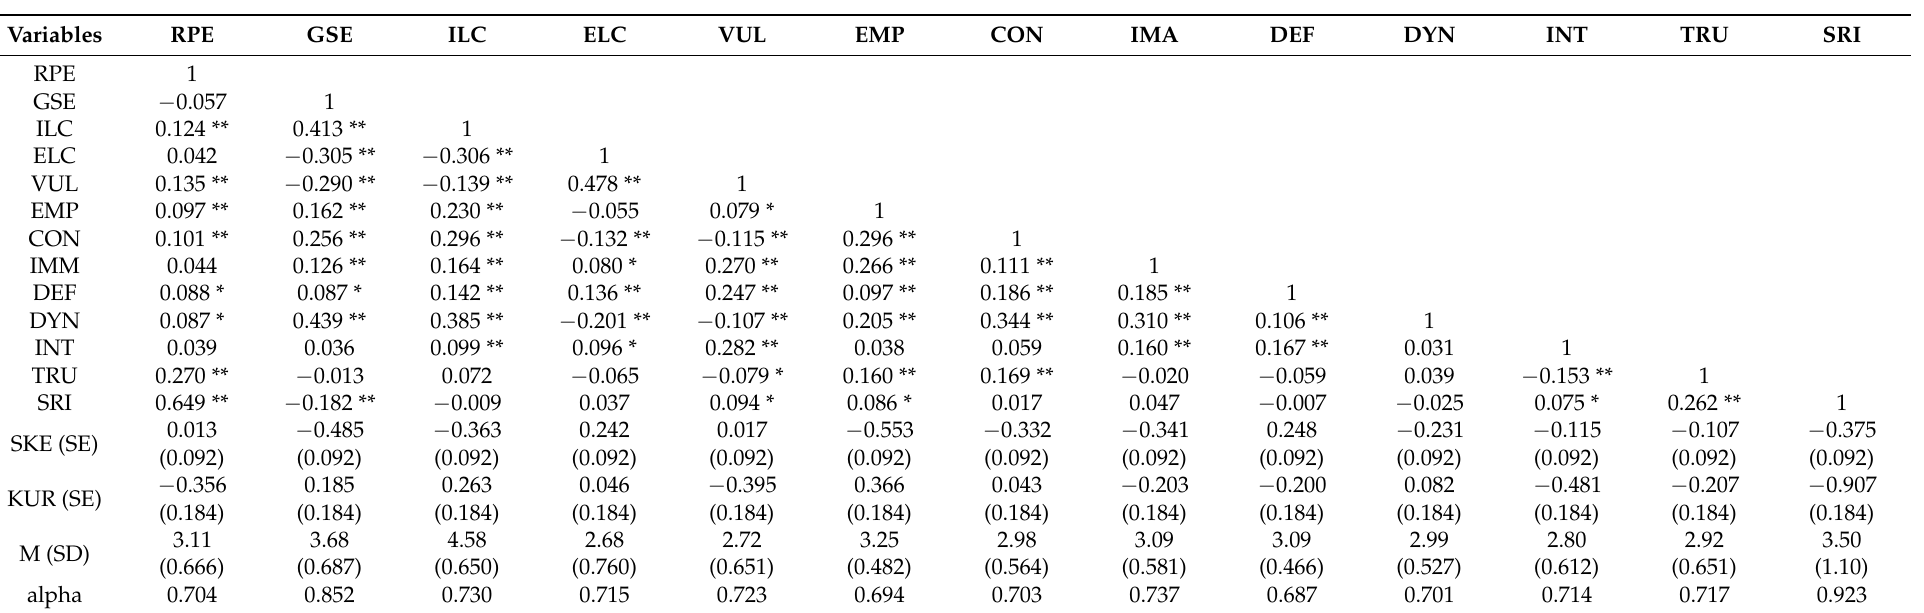
Table 7. Pearson’s bivariate